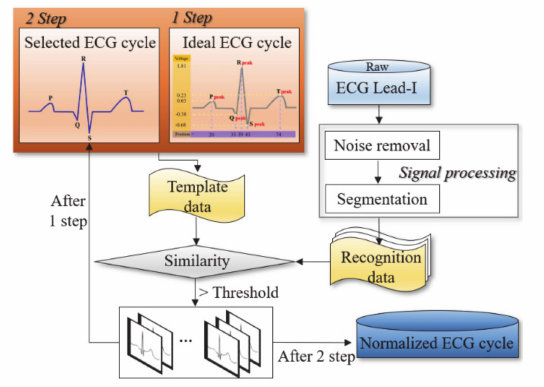
Figure 5. ECG normalization